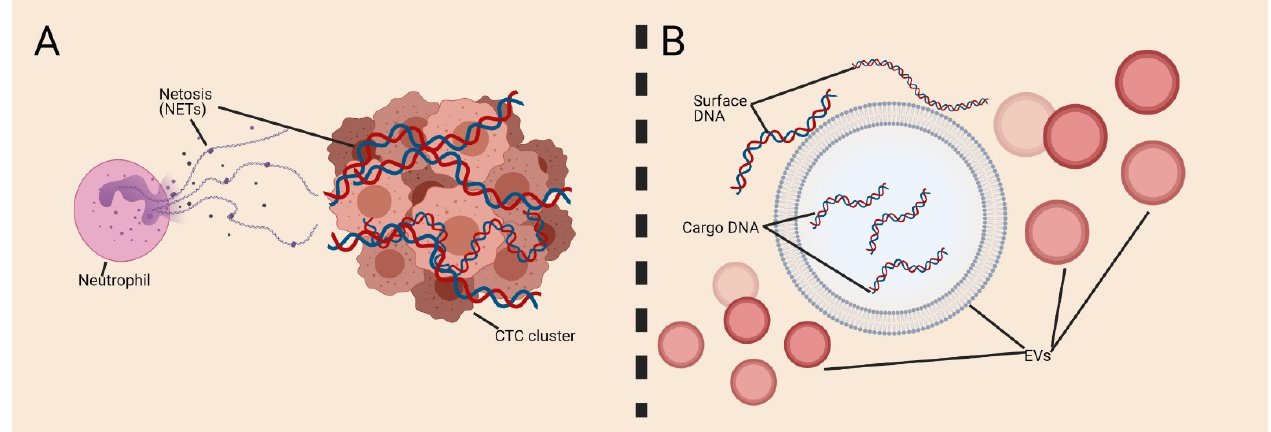
Figure 3. Surface DNA. Little is known about DNA interaction with circulating tumor cells (CTCs) or extracellular vesicles (EVs). ( A ) Neutrophils travel with CTC clusters in the bloodstream; this interaction might be facilitated by netosis with the formation of neutrophil extracellular traps (NETs) of DNA expelled from the neutrophil nucleus. ( B ) DNA may be present on the EV surface; however, few studies have been performed to understand this phenomenon.